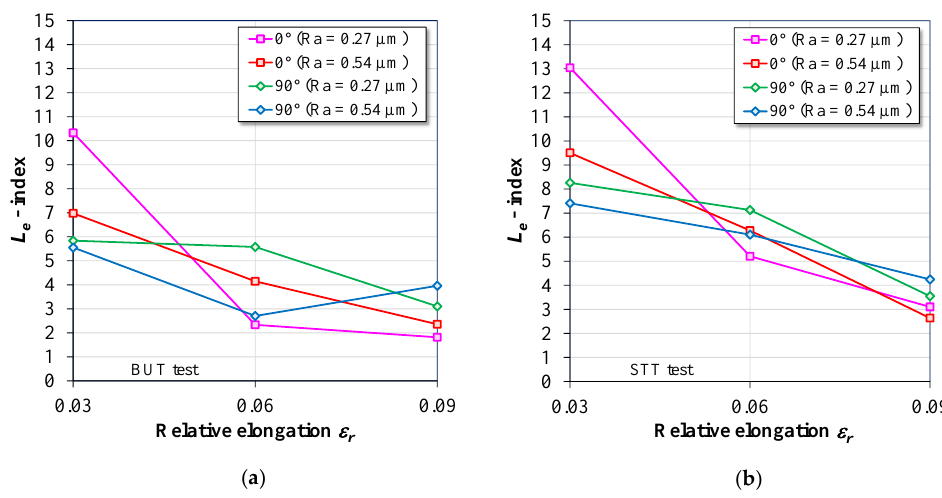
Figure 12. Effectiveness of lubrication ( 𝐿 𝑒 -index): ( a ) BUT test and ( b ) STT test.